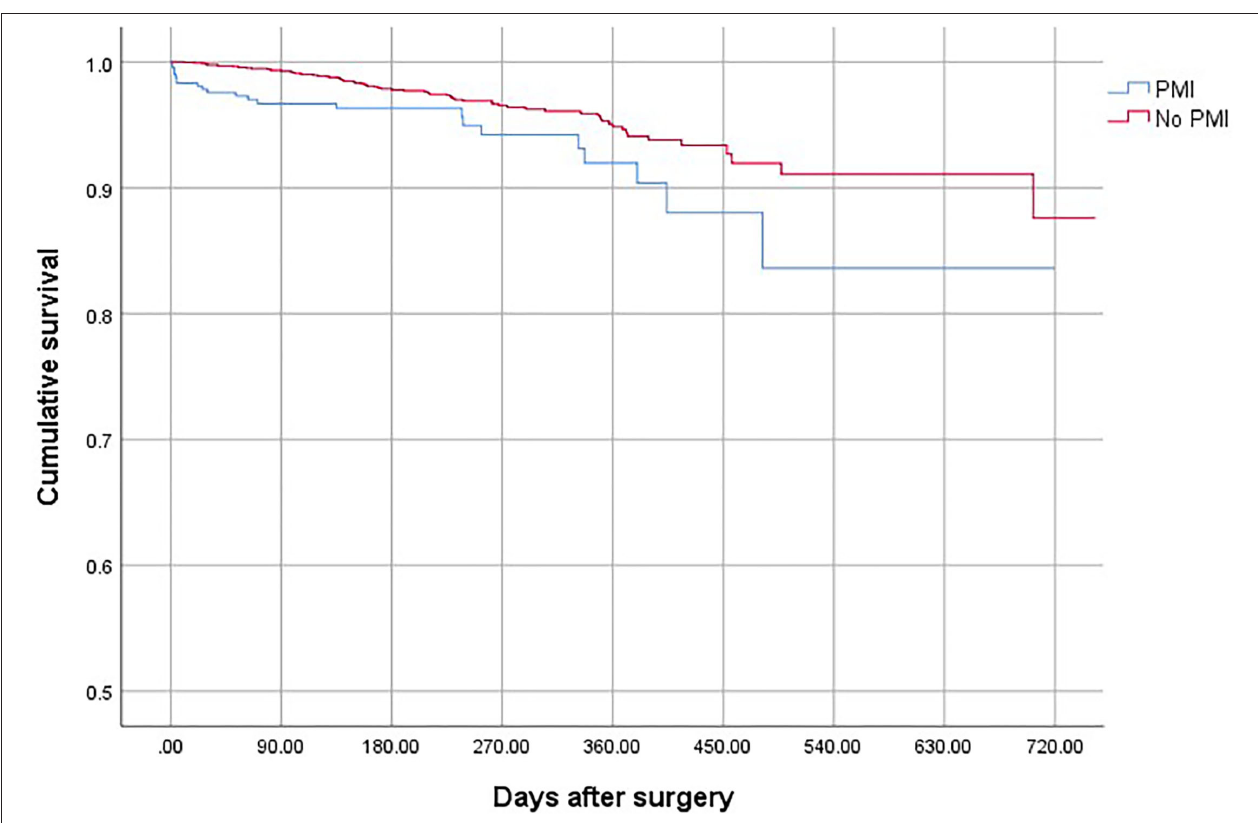
FIGURE 1 | The overall mortality of the patients with and without